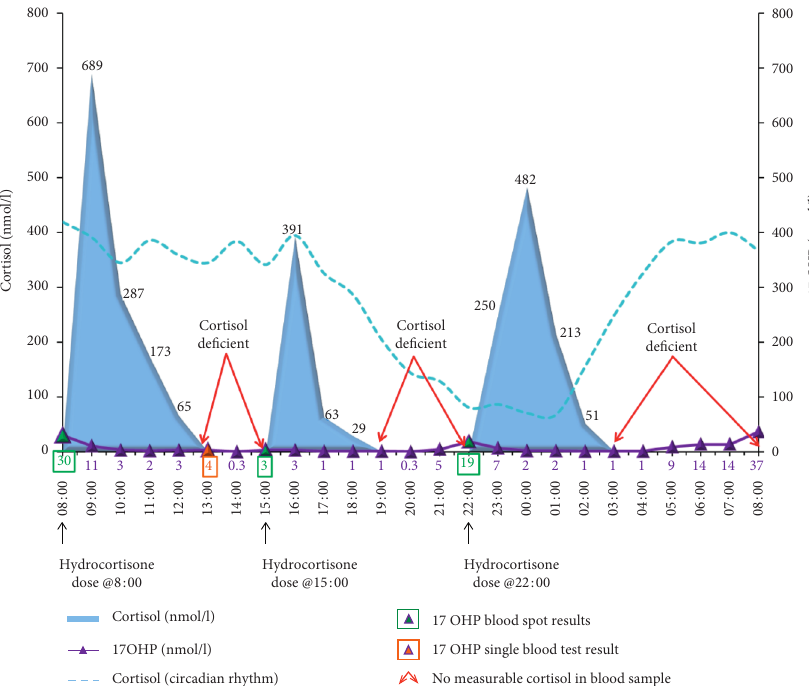
Figure 4: Plasma cortisol (filled area) and 17 hydroxyprogesterone (purple line with triangles) concentrations obtained after three oral doses of hydrocortisone given at 08:00 (7.5mg), 15:00 (5.0mg), and 22:00h (5.0mg) in a single 12-year-old pubertal female with salt-wasting congenital adrenal hyperplasia on hydrocortisone dosing of 12mg/m2/day and 9-alpha fludrocortisone dose of 100 micrograms per day. Average circadian plasma cortisol concentrations from the 28 short normal children are shown as the blue dashed line. Note the periods of time without cortisol and the rise in 17 hydroxyprogesterone concentrations from 04:00h. Blood spot 17 hydroxyprogesterone concentrations are shown in boxes (single sample in orange and several samples in green) for comparison. Blood sampling was at 1-hour intervals. Reproduced from Congenital Adrenal Hyperplasia: A Comprehensive Guide, Hindmarsh P and Geertsma K Elsevier, New York (2017).